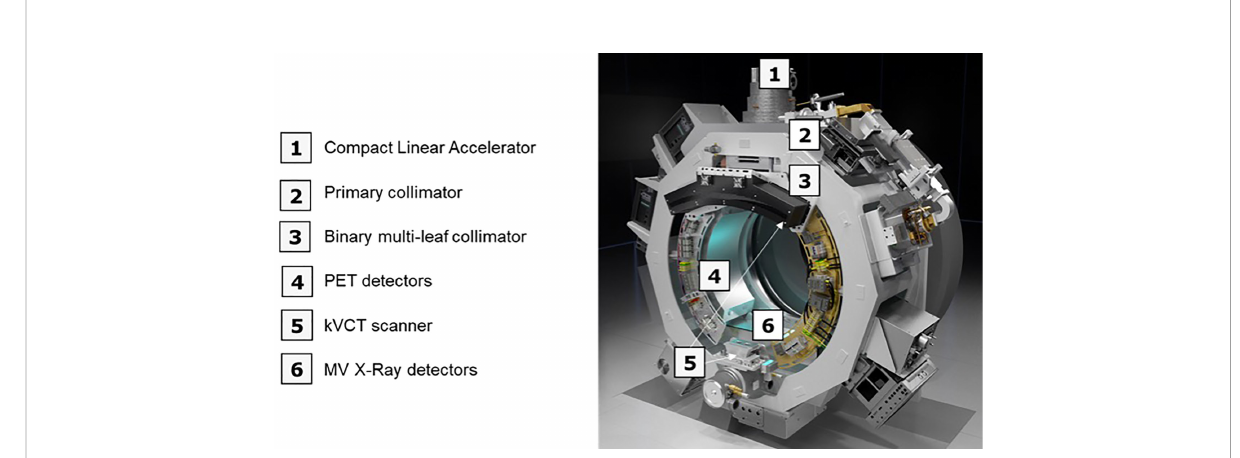
FIGURE 1 An overview of the X1 radiotherapy system showing the major components (without the couch